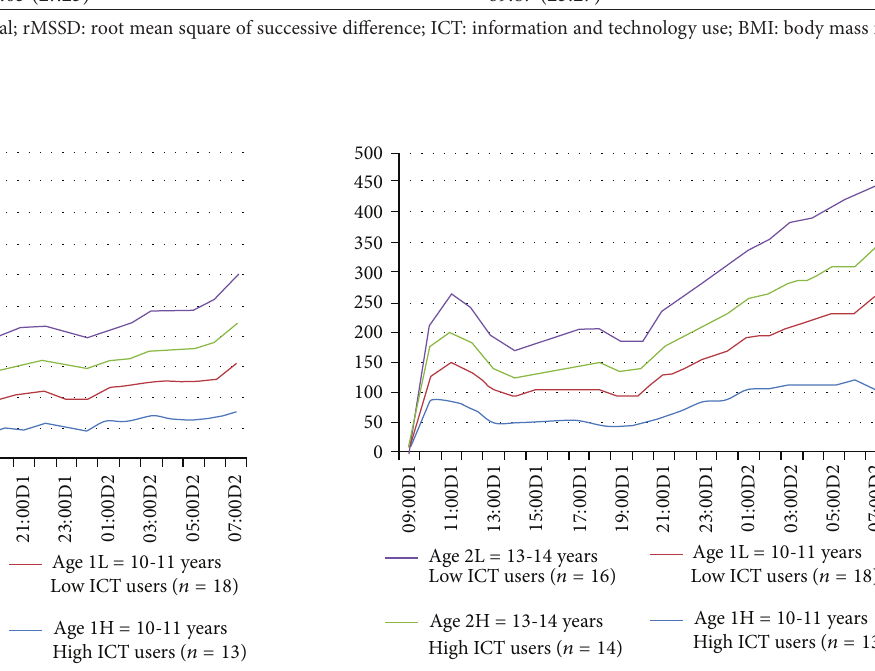
Figure 2: Mean HRV (rMSSD, ms) during a school day and at